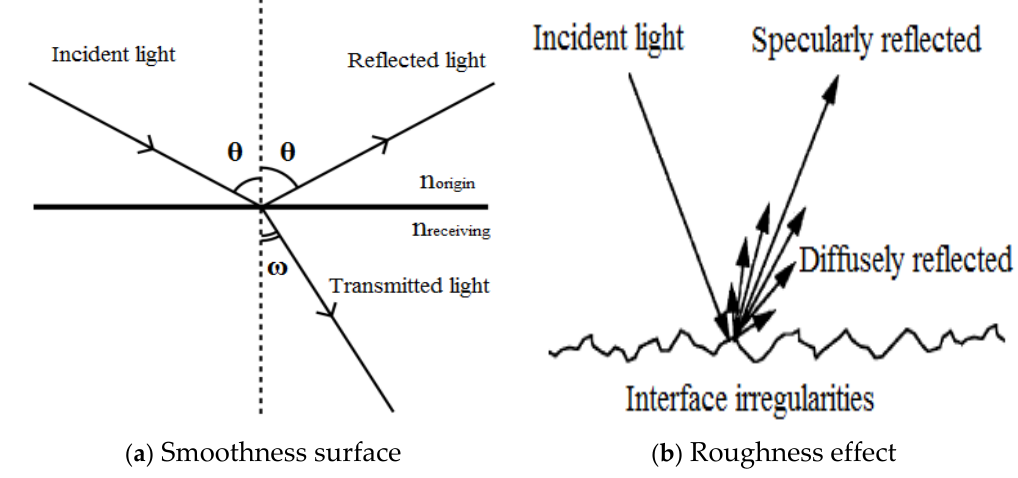
Figure 1. The figure illustrates the light ray interaction with the surface (the interface between the phosphor and the optical sensor) in case of: ( a ) smooth surface and ( b ) rough surface.